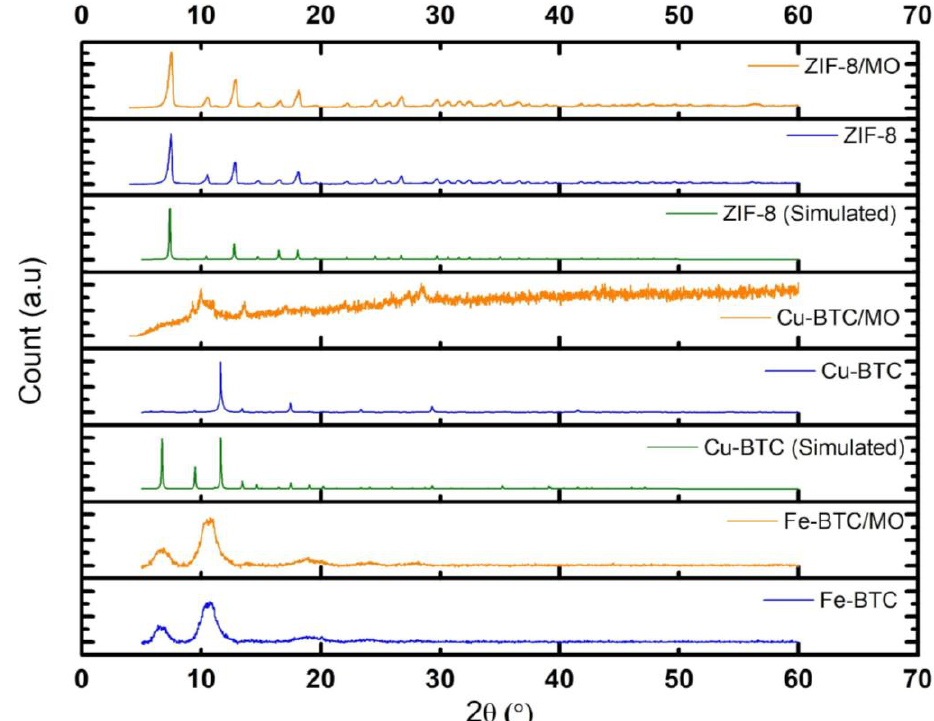
Figure 1. XRD patterns of MOF samples before and after MO adsorption. The simulated XRD patterns of Cu-BTC and ZIF-8 were sourced from the Cambridge Crystallographic Data Centre database.